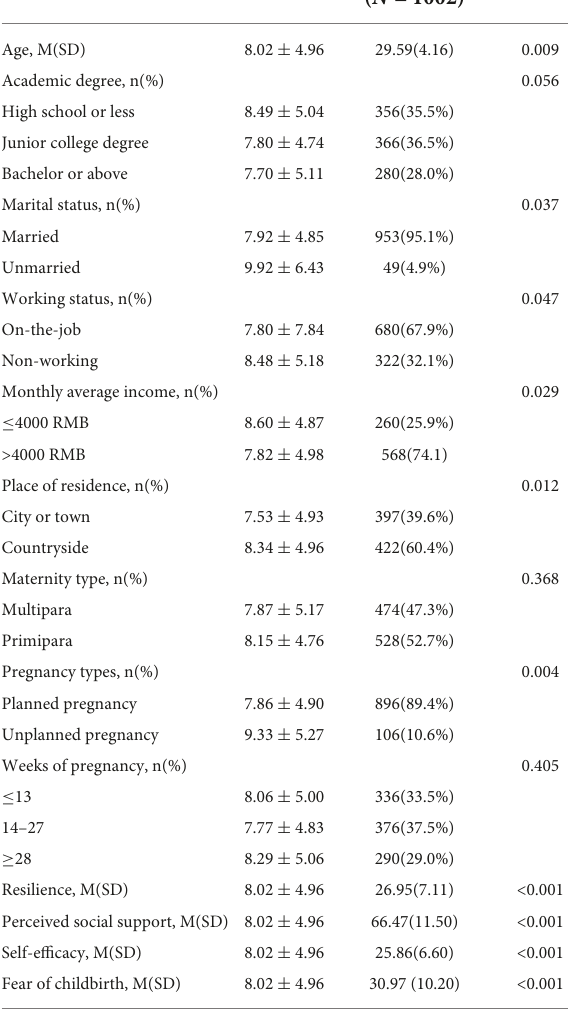
TABLE 2 When P = 4, the value-added contribution, average contribution and total average contribution of each predictor